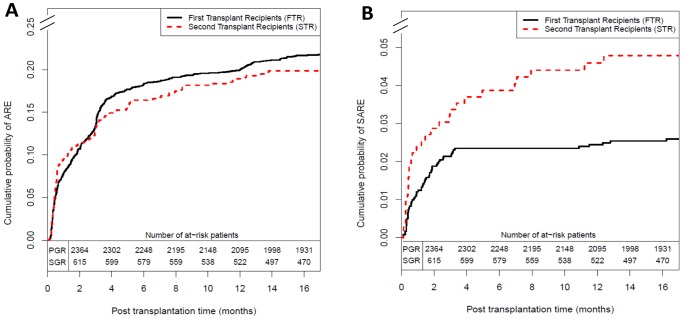
Cumulative probability of acute rejection episodes.(A) Cumulative probability of acute rejection episodes for FTR and STR (log-rank test: p = 0.4420) and (B) Cumulative probability of severe acute rejection episodes for FTR and STR (log-rank test: p = 0.0040), for first and second grafts (Kaplan-Meier estimates).